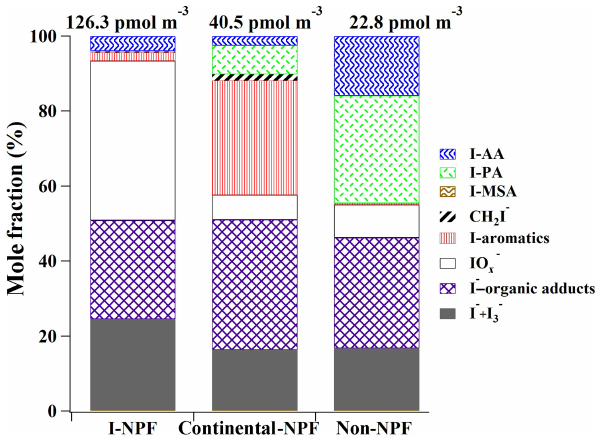
Figure 8. Total concentrations and mole fractions of io- dine species in 10nm–18µm particles during the iodine- induced NPF (I-NPF), continental NPF, and non-NPF